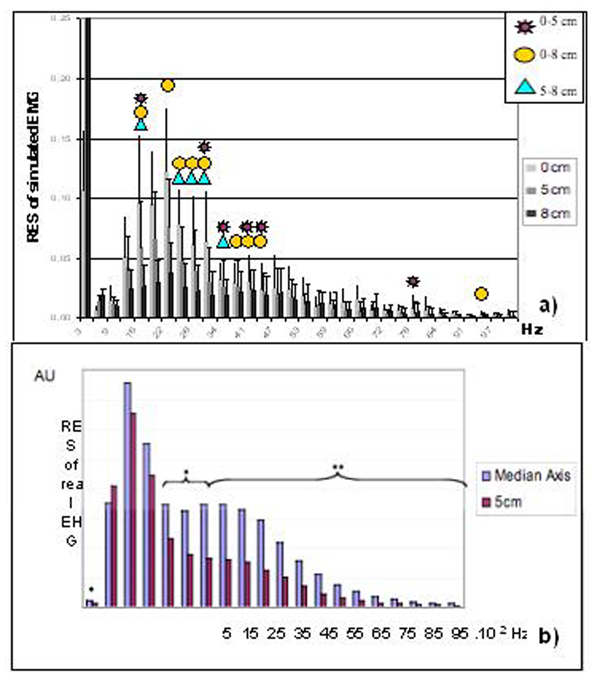
Analysis of electrode position on the relative energy spectrum of simulated and real uterine electromyograms. (a) Relative energy spectrum (RES) computed from simulated signals with three bipolar-electrode positions (see figure 2): d = 0 cm (Pair1), d = 5 cm (Pair2) and d = 8 cm (Pair3). The lowest frequency band has been truncated for a better visualisation of the other frequency bands. Significant differences resulting from the electrode positions are indicated by stars, circles and triangles, (p < 0.05). (b) RES computed from EHG recorded in pregnant women with two electrode positions: d = 0 cm (Median Axis) and d = 5 cm. (*p < 0.05; **p < 0.01). AU, arbitrary units.